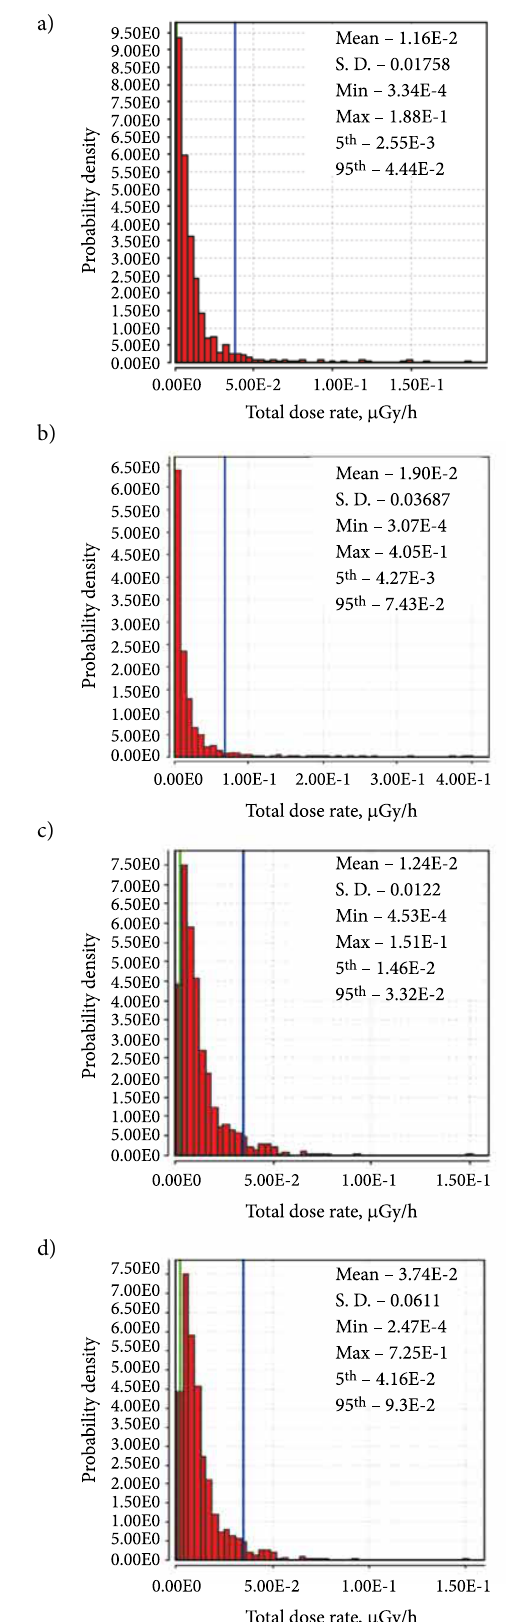
Fig. 5. Examples of estimated total dose rates to terrestrial refe- rence organisms attributed to artificial radionuclides after the Cher nobyl accident: lichen & bryophytes, 137 Cs (a); mammal (deer), 137 Cs (b); lichen & bryophytes, 90 Sr (c); and reptile 90 Sr